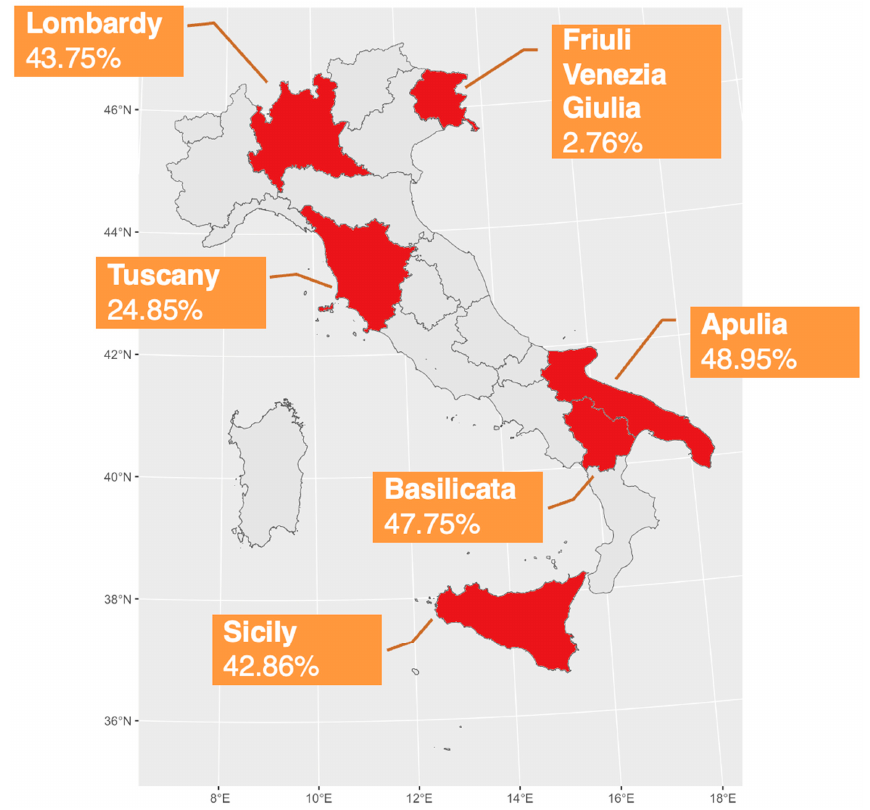
Figure A1. Geographical areas involved in the studies included in the analyses.